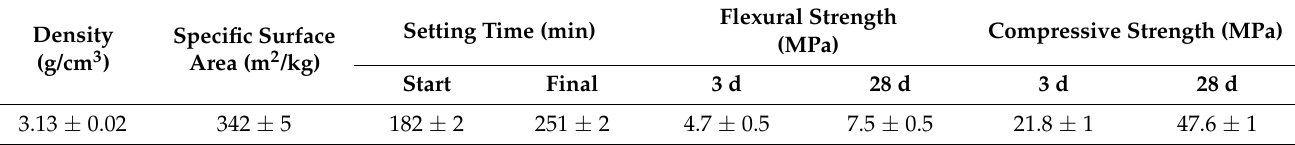
Table 3. Physical and mechanical properties of